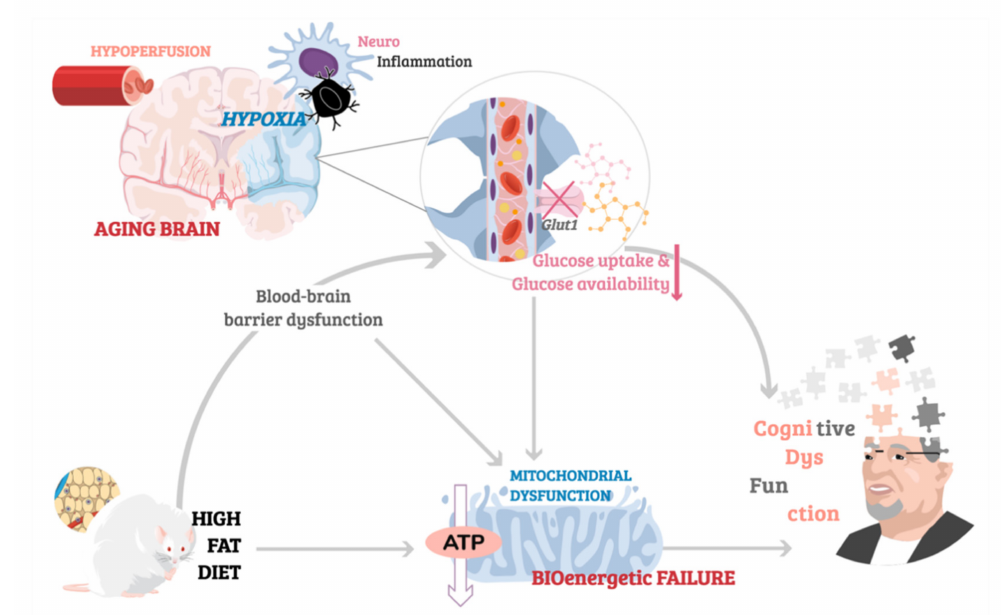
Figure 3. The aging brain, mitochondrial bioenergetic failure and cognition. The link be- tween age-related cerebrovascular dysfunction associated with hypoperfusion and neuroinflamma- tion, nutrition-induced dysregulation of blood-brain barrier permeability, breakdown of glucose metabolism and mitochondrial dysfunction implicated in cognitive impairment in later